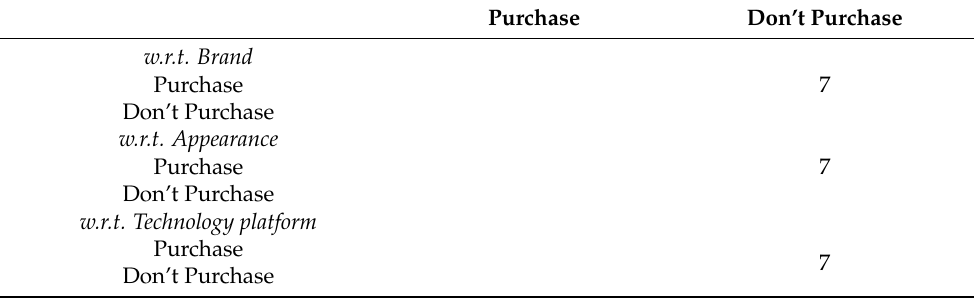
Table 15. Pairwise comparison matrix of Purchase and Don’t Purchase decision with respect to sub-criteria of CAR IDENTITY.